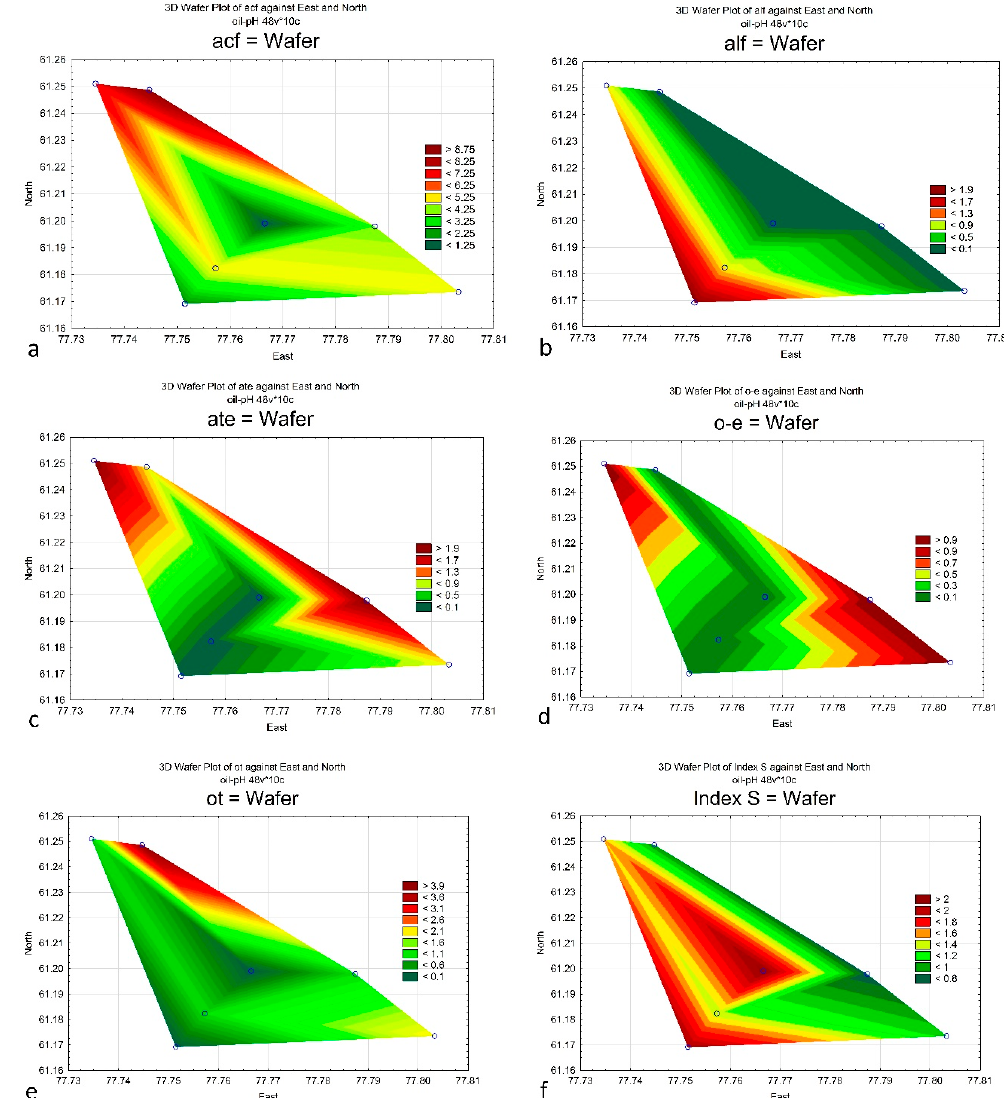
Figure 6. Distribution maps for Index saprobity S and species indicators: acidophiles ( a ), alkaliphiles ( b ), ologo-eutraphentes ( c ) species with autotropic nutrition ( d ), oligotrophic water indicators ( e ), and Index saprobity S ( f ) in seven studied sites of the bogs of the Ershov oil field in the Vakh River basin of the